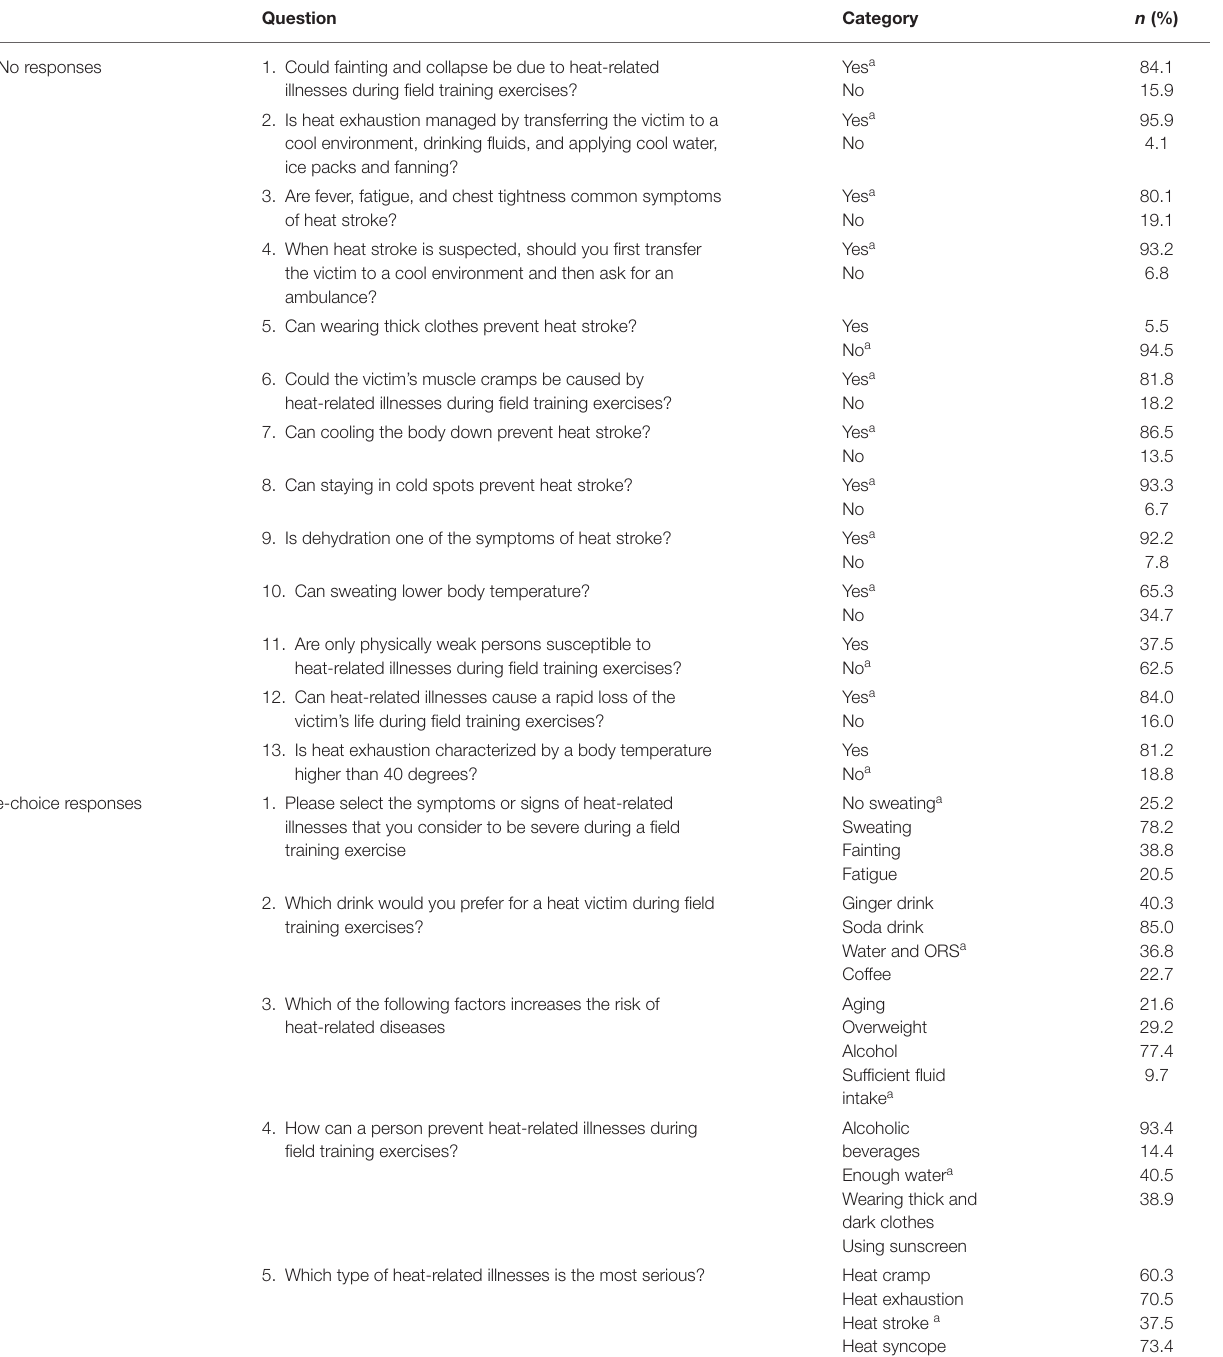
TABLE 2 | Responses to knowledge items ( n =